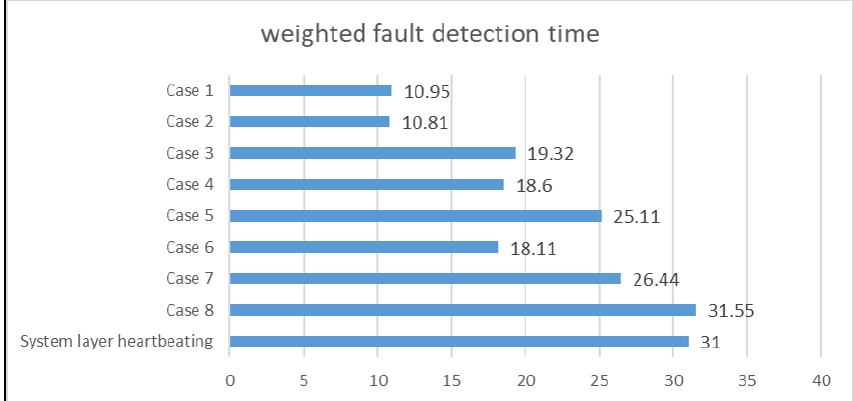
Figure 6. Comparison of weighted fault detection time (in